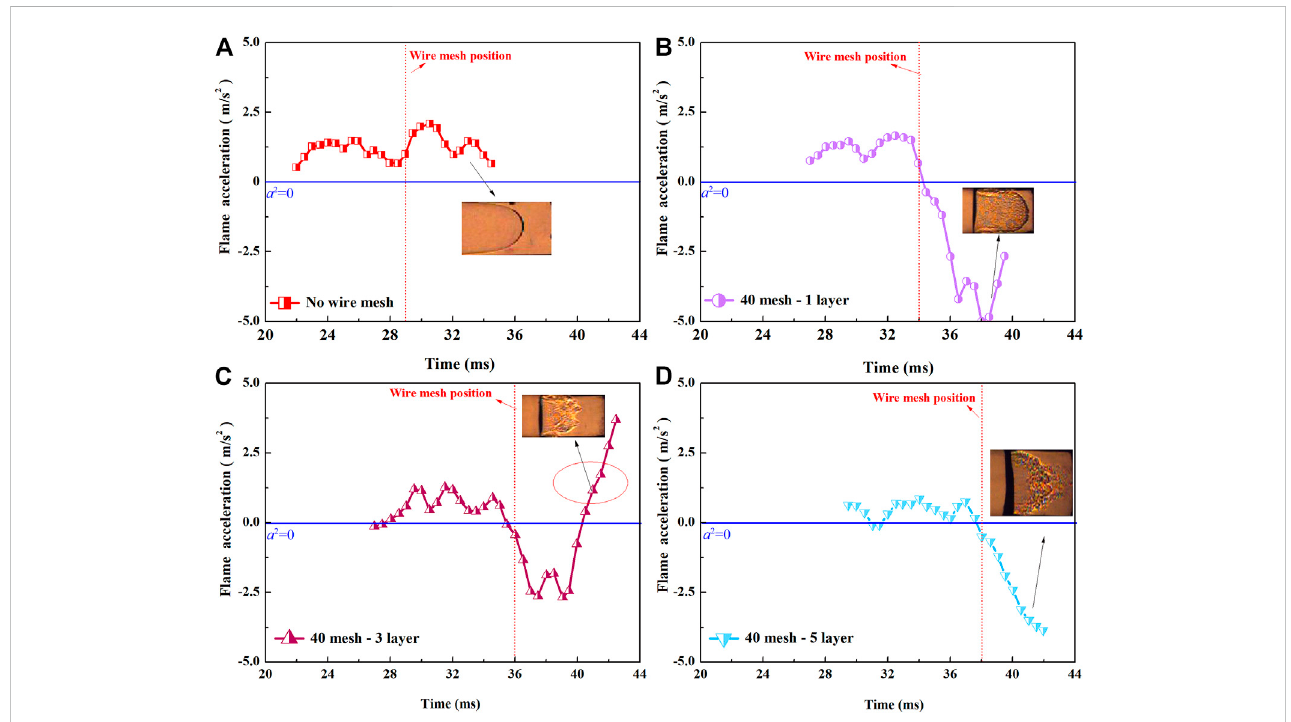
FIGURE 6 Flame acceleration under different wire mesh layers. (A) No mesh, (B) 1 layer, (C) 3 layer, (D) 5 layer.